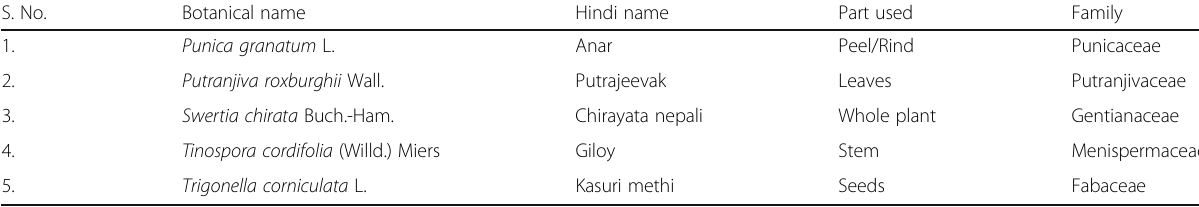
Table 1 Details of five plant parts used with botanical and vernacular